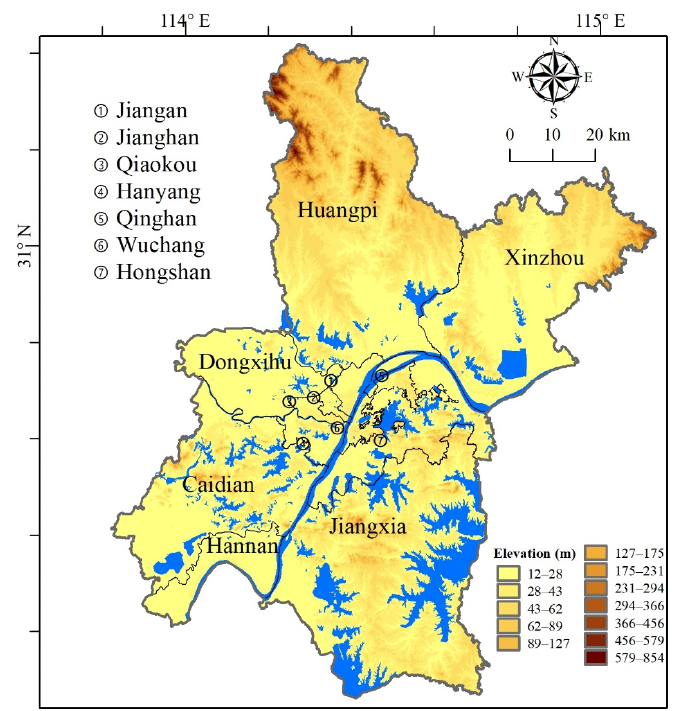
Figure 1. Location of the Wuhan Urban Agglomeration Area.